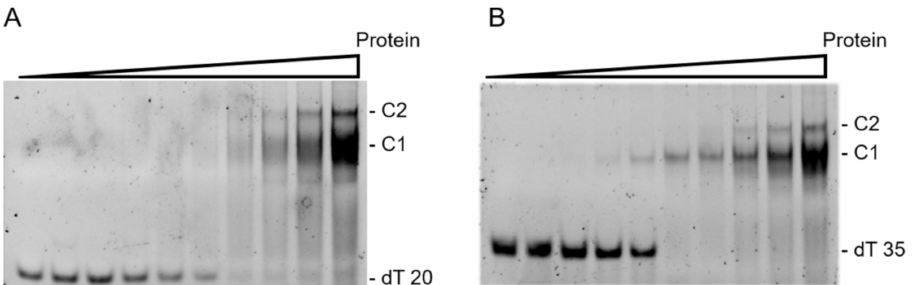
Figure 3. Gel shift assay for Binding of LjSSB with dT20 and dT35. LjSSB (0, 0.125, 0.25, 0.5, 1, 2, 4, 8, 16, and 32 µ M) was incubated with 500 nM of dT oligomers. ( A ) dT20 and ( B ) dT35 incubated with LjSSBs. C1 and C2 refer to complex 1 and complex 2, respectively.